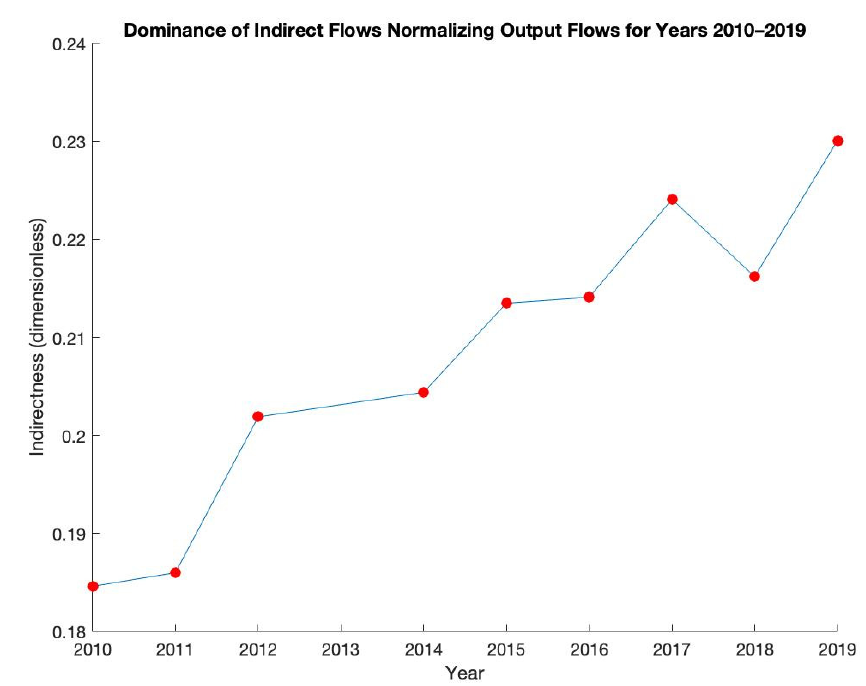
Figure 7. Indirectness normalizing output flows for Maryland’s energy industry from 2010–2019.